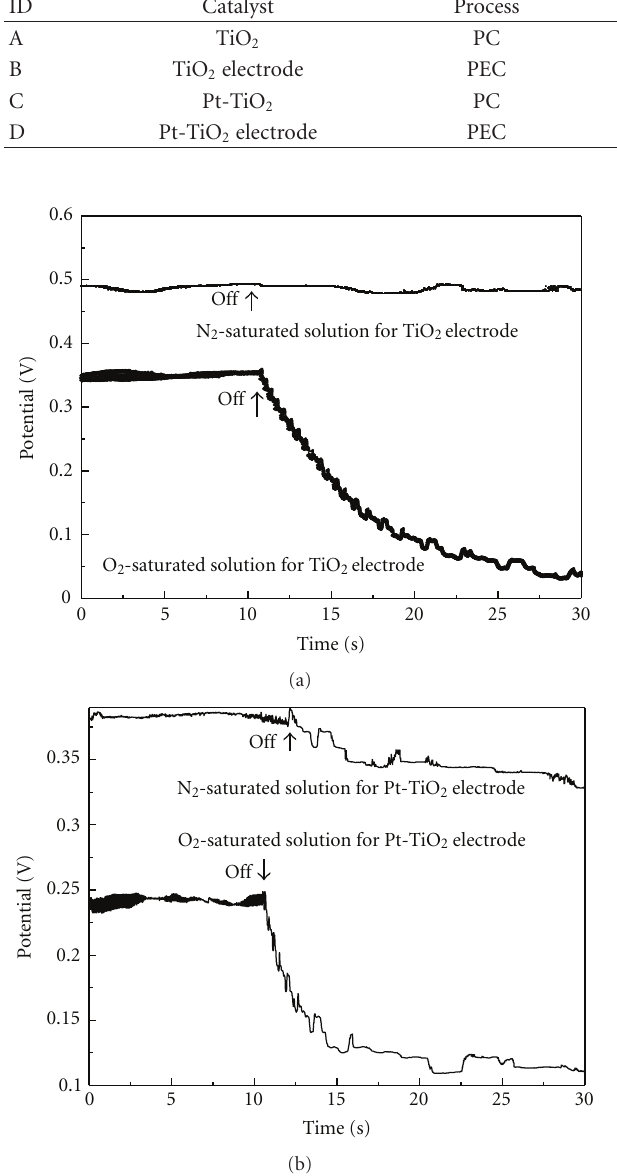
Figure 5: Decay curves of open circuit voltage after light was turned o ff (a) TiO 2 film and (b) Pt-TiO 2 .